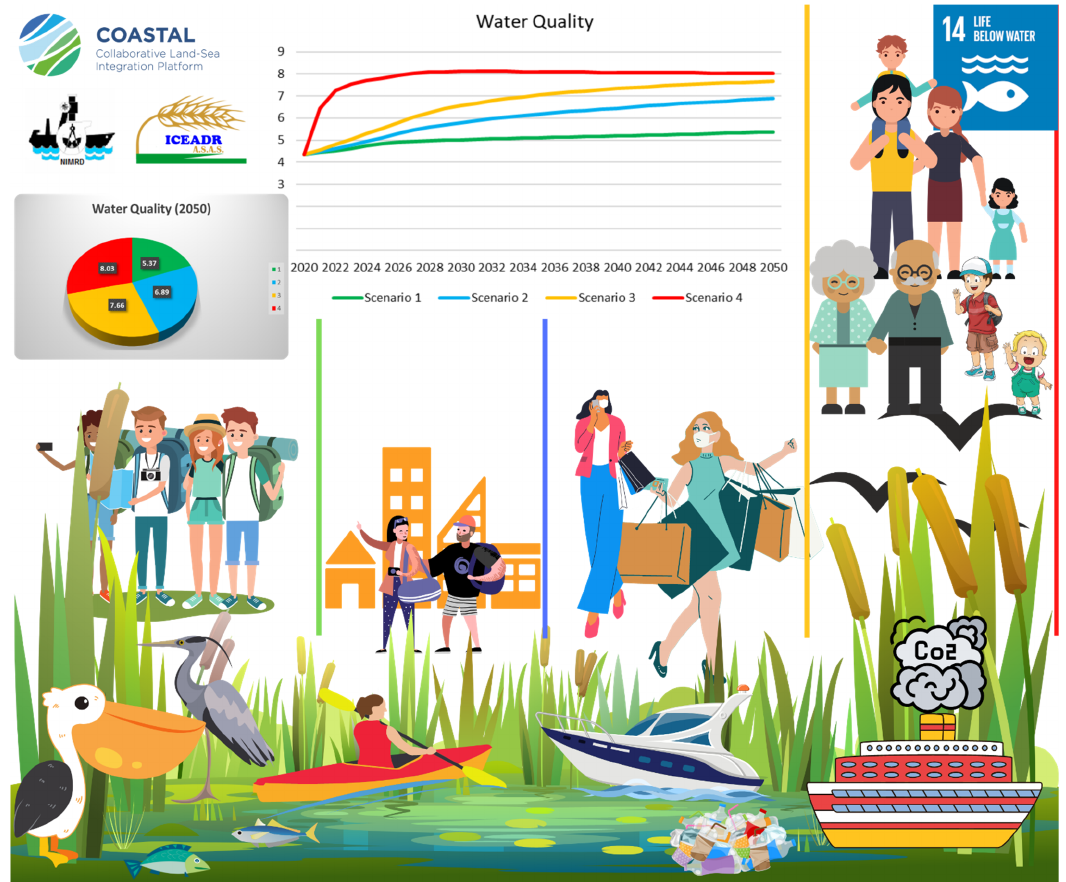
Figure 7. Water quality evolution in relation to different scenarios of the Danube Delta develop- ment.